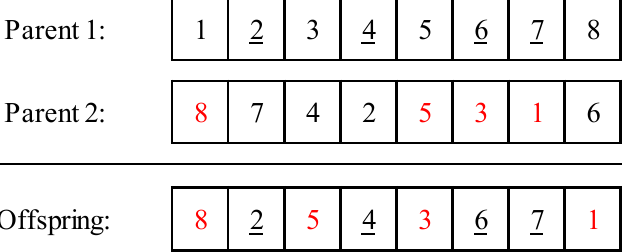
Figure 2. Example of a position-based crossover (PBX) operator.